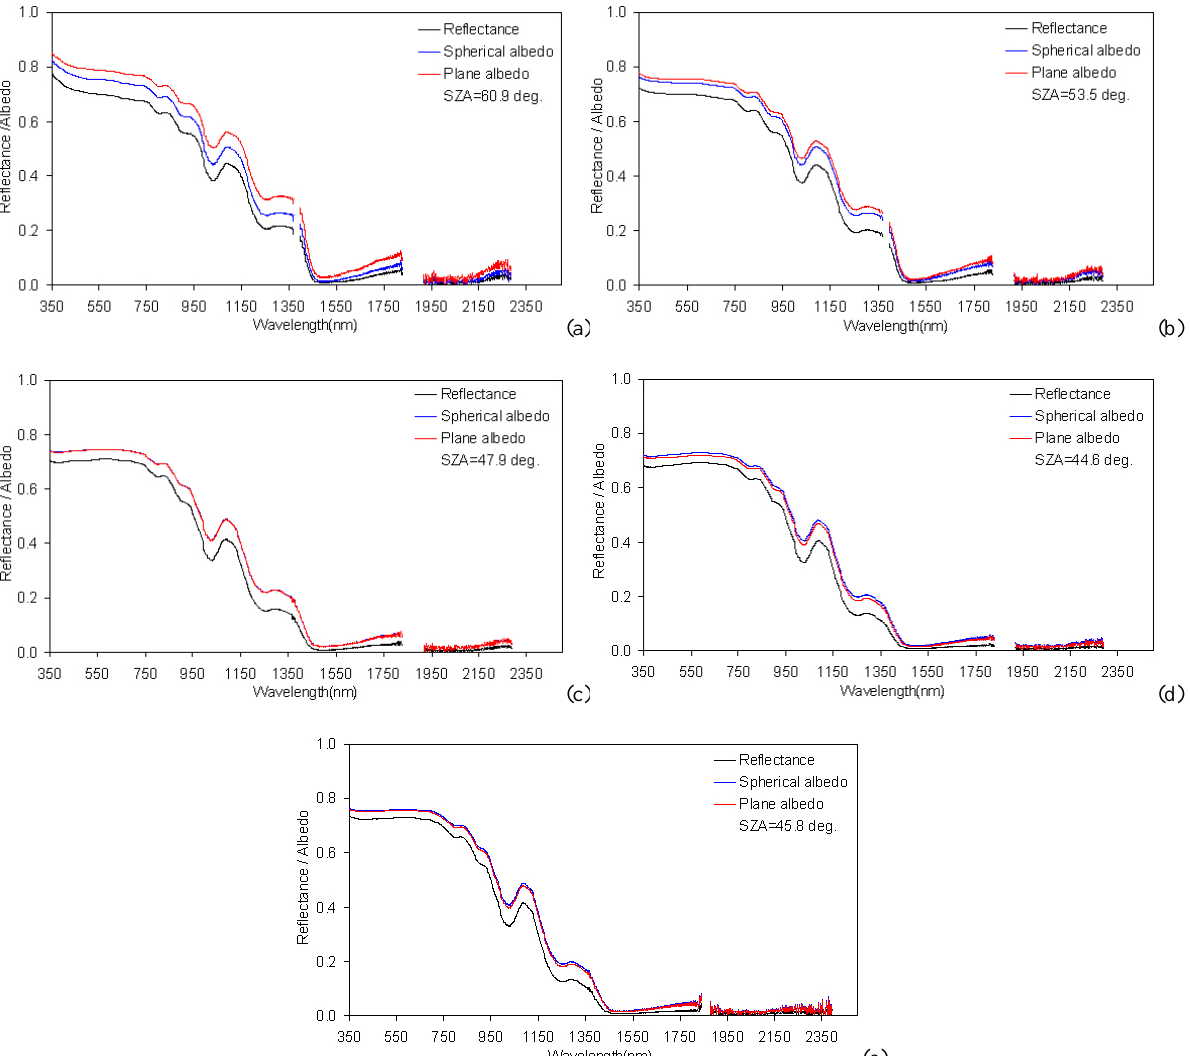
Fig. 4. Field measured reflectance for snow Type-II (old snow) and simulated spherical and plane albedo; (a) 09:20, (b) 10:10, (c) 11:00, (d) 12:00 and (e) 13:00 local